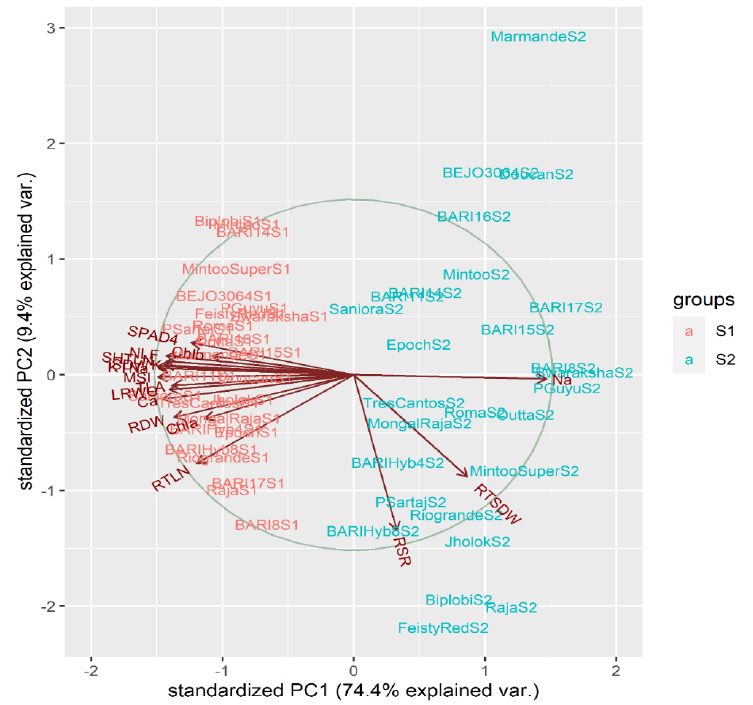
Figure 2. Three-way principal component biplot (PC-biplot) for genotypes × salinity levels × physio-morphological attribute responses with 27 tomato accessions at the early growth stage under non-salinized control (S1) with 18.2 mM NaCl and salinized (S2) with 200 mM NaCl conditions during 2018–2019. The two PCs (PC1 and PC2) described 74.4% and 9.4% of the variance, respectively. Arrows indicate the intensity of the plant characters effects in the first two components. The arrows’ direction and distance show the extent of traits influencing the first two PCs. Aligned vectors suggested a significant positive relationship between the two plant characters. Vectors at perpendicular and opposing forces revealed no association and negative association, respectively (TLA = total leaf area per plant (cm 2 ), NLF = number of leaves per plant, SPAD1 = SPAD value at first week of salt stress, SPAD4 = SPAD value at fourth week of salt stress, Chla = chlorophyll a concentration of fresh leaves (mg g − 1 fresh mass), Chlb = chlorophyll b concentration of fresh leaves (mg g − 1 fresh mass), LRWC = leaf relative water content (%), MSI = membrane stability index of fresh leaves, SHTLN = shoot length (cm), RTLN = root length (cm), RSLR = root to shoot length ratio, SDW = shoot dry weight per plant (g), RDW = root dry weight per plant (g), RSDW = root to shoot dry weight ratio, Na = sodium content in leaf (mmol/g DW), K = potassium content in leaf (mmol/g DW), Ca = calcium content in leaf (mmol/g DW), and KTNa = potassium to sodium content ratio in